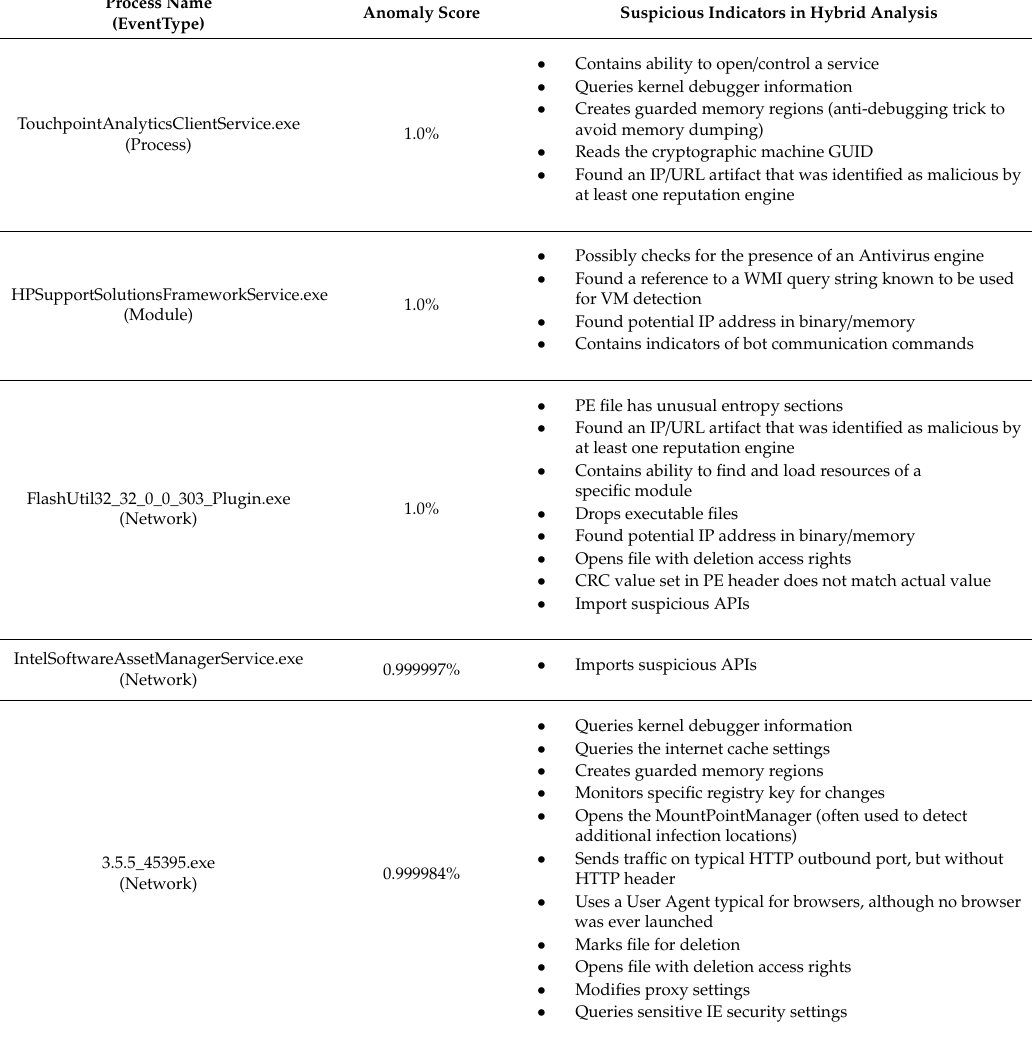
Table 7. AutoEncoder based single suspicious event analysis